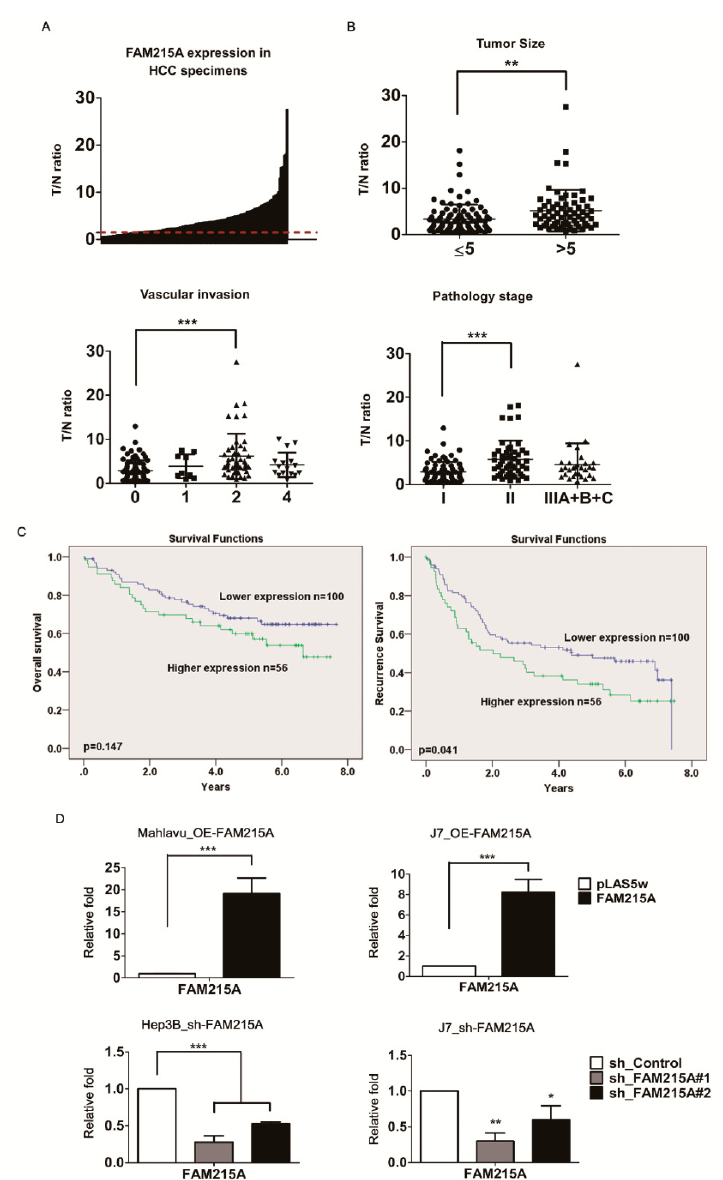
Figure 1. FAM215A dysregulated in HCC and correlated with HCC tumorigenesis. To verify the role and expression of FAM215A in 156 pairs of HCC clinical specimens by qRT-PCR. ( A ) FAM215A is highly expressed in 156 pairs of HCC specimens. ( B ) Clinical significance of FAM215A. ( C ) Overall survival or recurrence free survival. The average value of expression is the cuto ff (high or low). ( D ) Overexpression or depletion of FAM215A cells by using lentivirus. Expression of FAM215A was determined by qRT-PCR. 18s rRNA was used as the loading controls. Data are presented as means ± s.d. (* p < 0.05; ** p < 0.01; *** p < 0.001) of three independent experiments. Data show as tumor / adjacent normal (T / N ratio). Vascular invasion: 0. Absent, 1. Capsular vein invasion, 2. Portal vein tumor thrombosis (micro), 3. Portal vein tumor thrombosis (grossly) and 4. Portal vein tumor thrombosis (gross and micro). Pathology stage is according to TNM stage: Stage I. T1, Stage II. T2 and Stage III. T3-4. The square, triangle and circle are used to indicate the labels of di ff erent pathological groups.